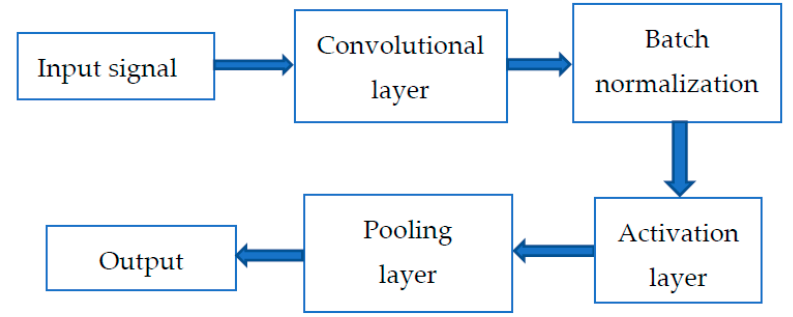
Figure 3. The structure of the convolution block.